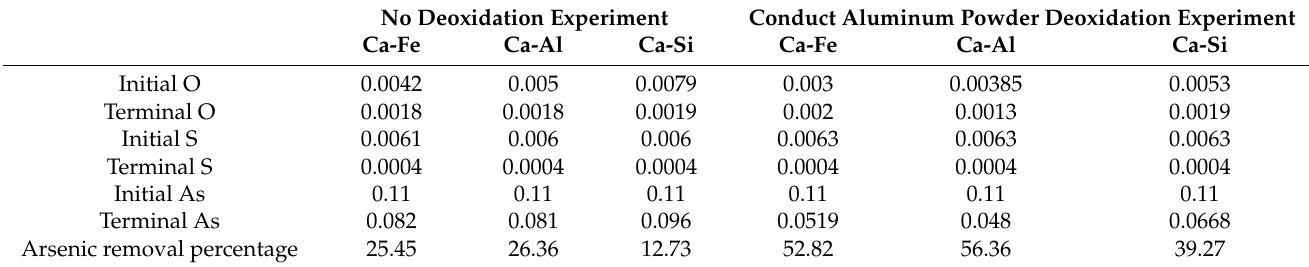
Table 3. Change in element content in molten steel